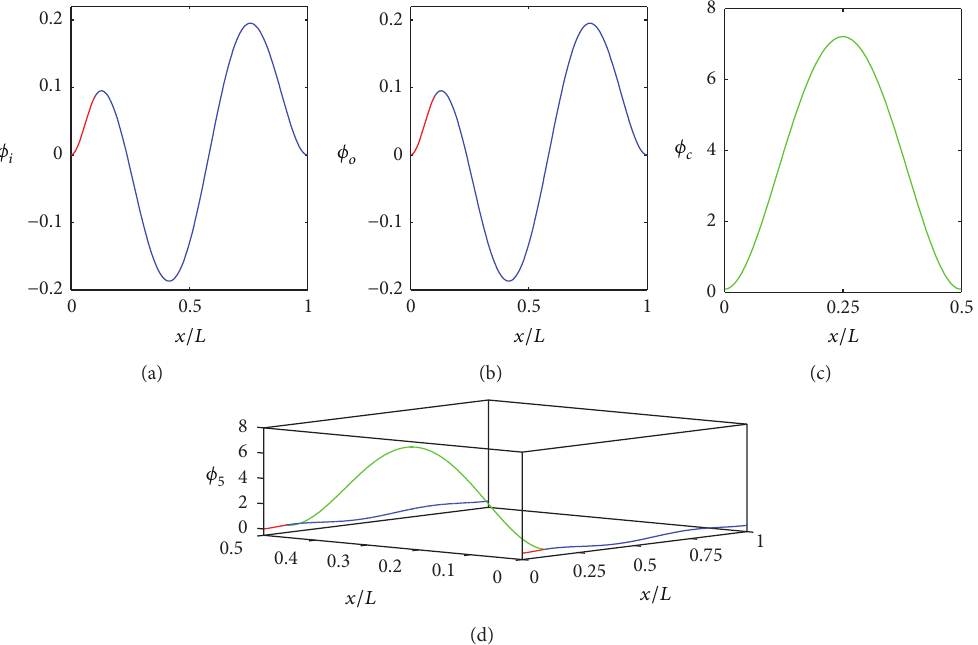
Figure 6: Fifth mode shape of the filter: (a) input, (b) output, (c) coupling beams, and (d) combination of (a), (b), and (c).